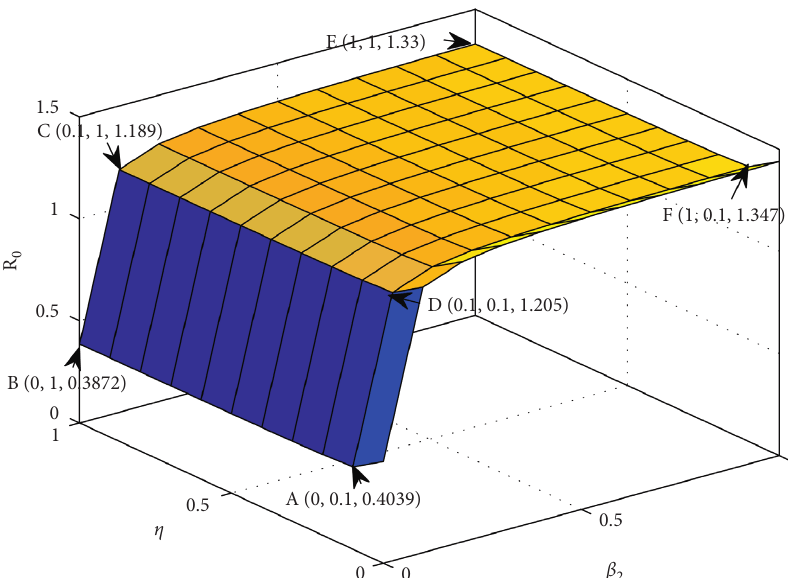
Figure 3: The simulation of the reproduction number versus parameters β